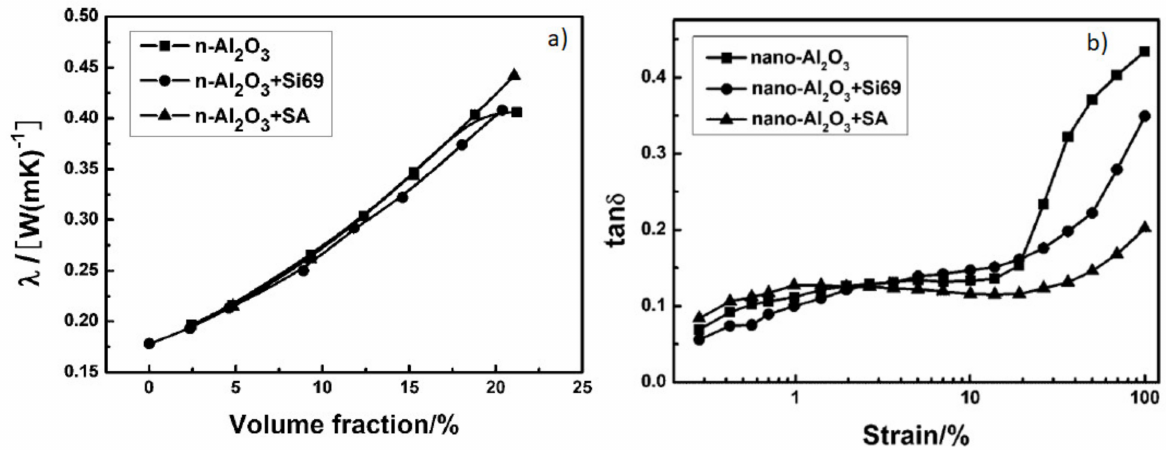
Figure 10. ( a ) Trend of the thermal conductivity ( λ ) of EPDM nanocomposites as a function of α -Al 2 O 3 filler volume fraction; ( b ) tan δ of α -Al 2 O 3 /EPDM nanocomposites vs. strain at a filler loading of 149 phr [97]. Copyright © 2021 John Wiley & Sons, Ltd. All rights